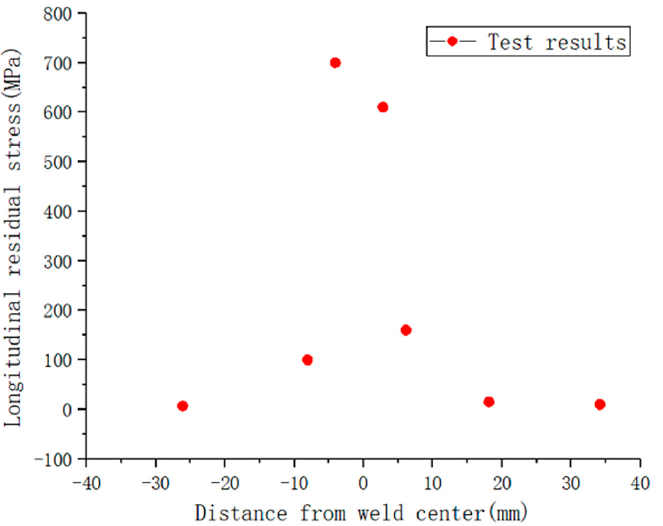
Figure 3. Measured data of longitudinal residual stress along vertical weld path.